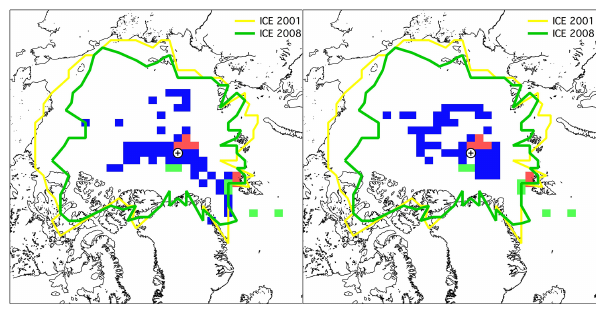
Figure 12. Geographic distribution of back trajectories for the three clusters in Fig. 11 with joint occurrences of at least 25 trajectory hits per geocell. Left: for cluster 1 only cases without particles less than 10nm measured on Oden were considered. Right: for cluster 1 only cases with particle concentrations less than 10nm > 1cm − 3 measured on Oden were considered. The cluster coloring corre- sponds to that in Fig. 11. Colored lines: 10% limits of sea ice cover north of 76 ◦ N estimated from average sea concentrations (https://nsidc.org/data) during the Oden cruises of 2001 and 2008.